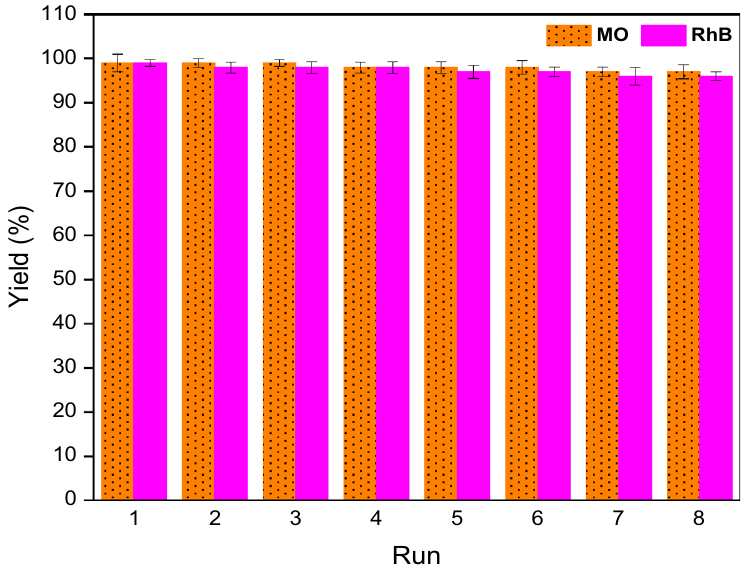
Figure 7. The results of the recyclability of the catalyst for reduction of MO and